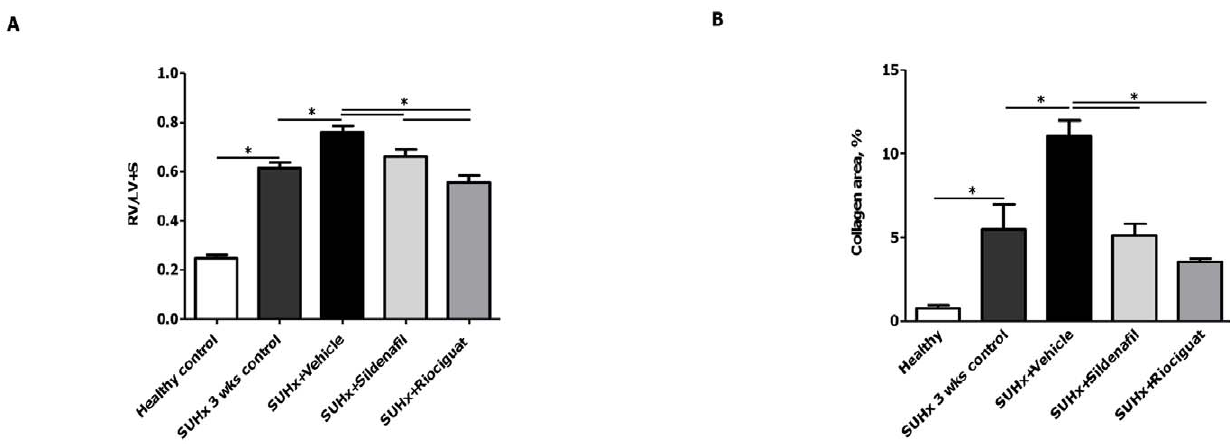
Figure 2. Effects of riociguat and sildenafil on RVH and fibrosis in SUHx rats. (A) Ratio of the RV to LV + S and (B) RV collagen contents of different treatment groups. * p , 0.05. Note. LV, left ventricle; RV, right ventricle; RVH, right ventricular hypertrophy; S, interventricular septum.